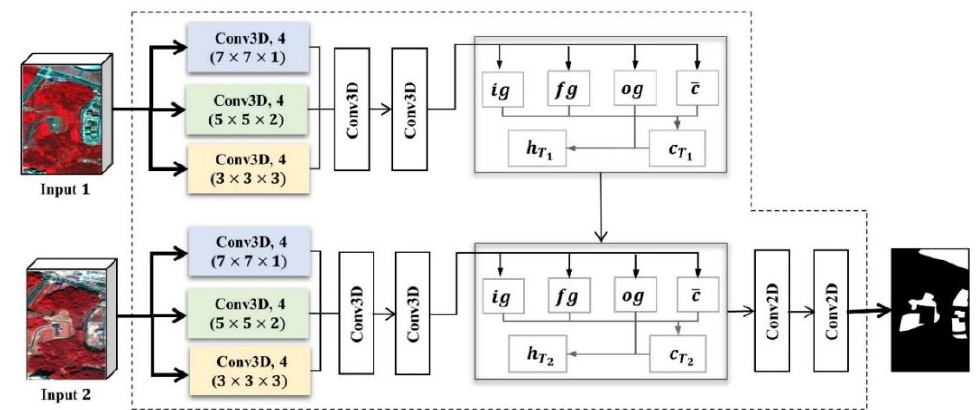
Figure 2. Architecture of the proposed change detection network, with “Conv2D” representing the 2D convolutional layer. “ ig ”, “ fg ”, “ og ”, “ c ”,“ c ”, and “ h ” represent input gate, forget gate, output gate, candidate memory cell, memory cell, and hidden state, respectively. The colored layers exploit the pre-trained weights and biases from semantic segmentation